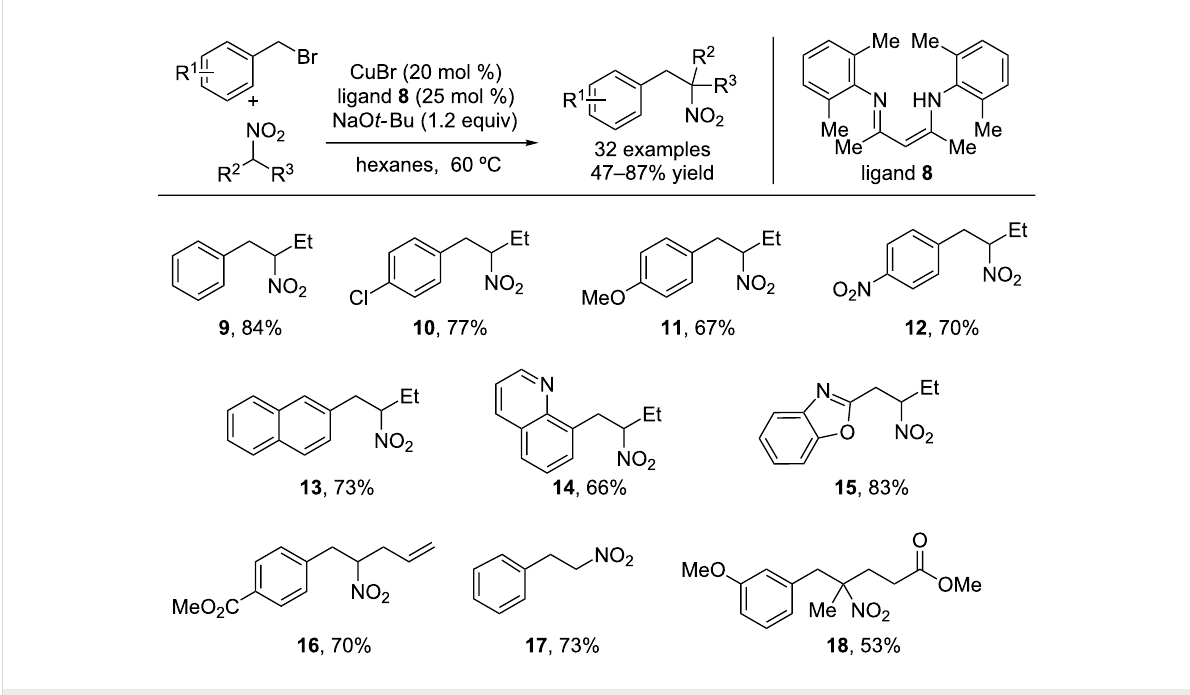
Scheme 3: Scope of the copper-catalyzed nitroalkane benzylation.